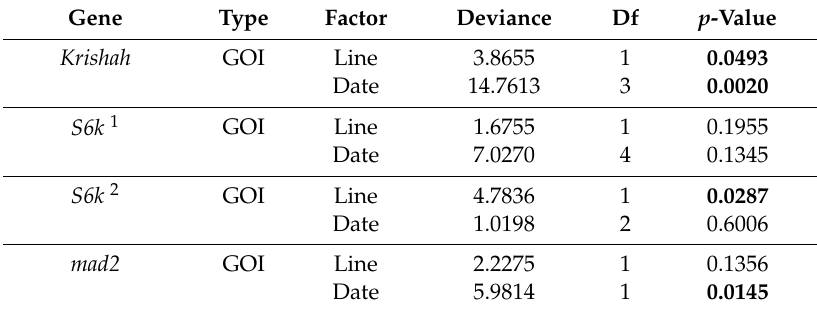
Figure 2. Survival of GOI lines versus empty cassette controls (attP40 control line 36304). ( A ) krishah ( kri , Line 62238) infected with E. faecalis at a dose of OD = 1.5; ( B ) S6 kinase ( S6k , Line 42572) infected with E. faecalis at a dose of OD = 1.5; ( C ) S6 kinase ( S6k , Line 42572) infected with E. faecalis at a dose of OD = 2.4. In all cases, infections were conducted across multiple days. As such, the y axis is the residuals from a model controlling for Date effects. Table 1. Results of generalized linear models with a binomial distribution and a logit link fitted to survival data after E. faecalis (EF) infection. Genes of Interest (GOI) are listed above their genomic neighbor comparison. DF is degrees of freedom. p values less than 0.05 are shown in